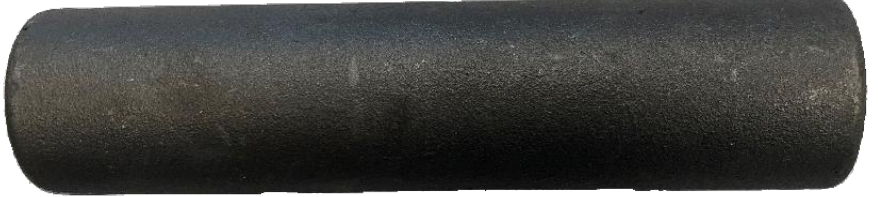
Figure A1. Raw cylinders cast from EN-GJS-500-14 material.